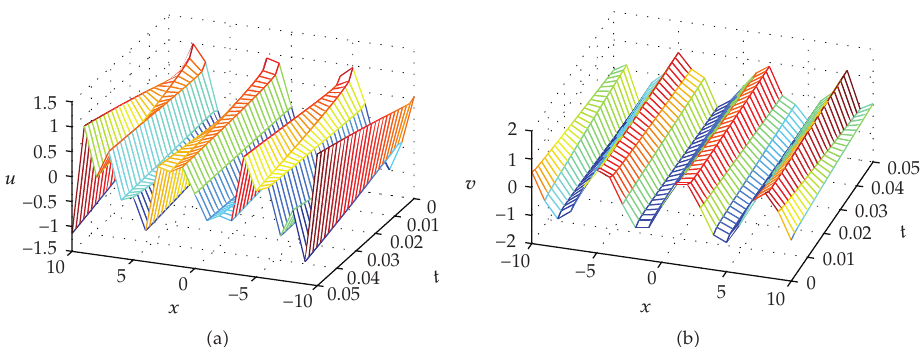
Figure 3: Explicit numerical solutions with h (cid:8) − 1, α (cid:8) 1 / 4, and β (cid:8) 1 / 3.